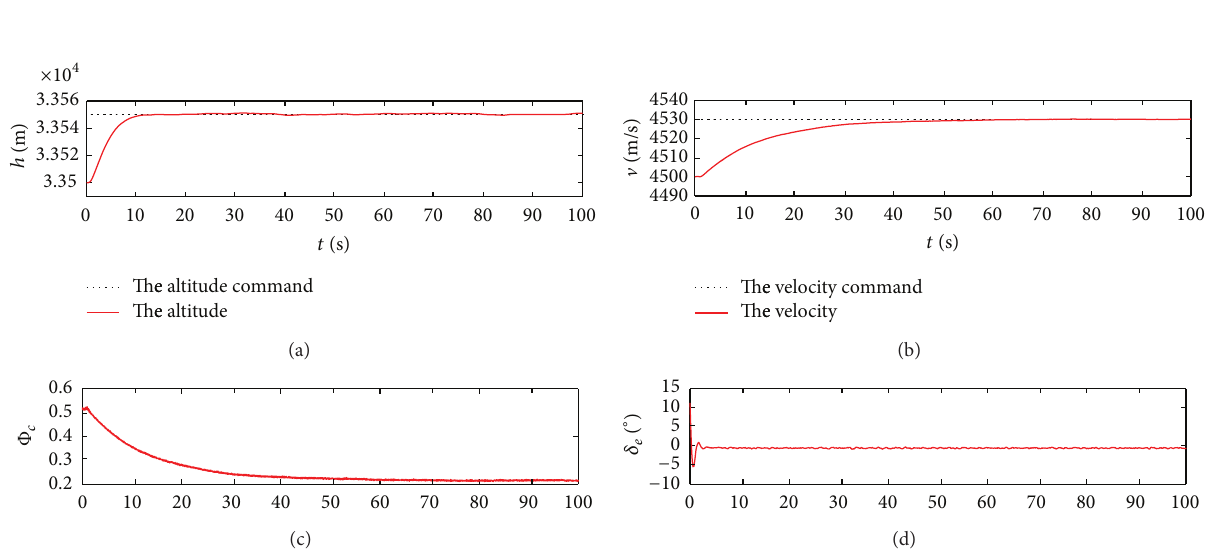
Figure 8: Change curves of the control inputs and angle of attack.